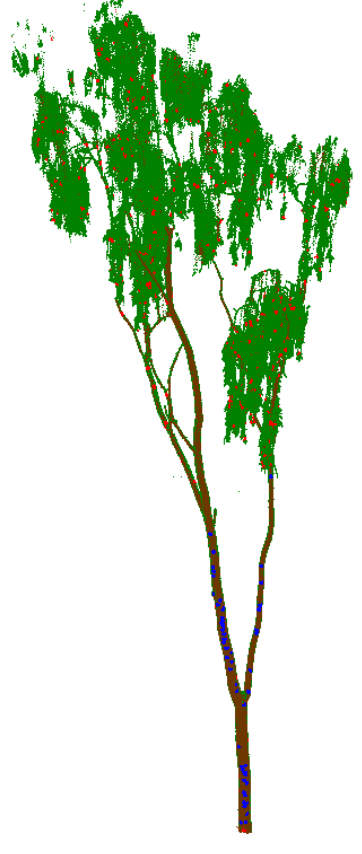
Figure 6. Display diagram of sampling results of tree 5. Brown: wood points; green: leaf points; blue point: sampled wood points; red point: sampled leaf points.